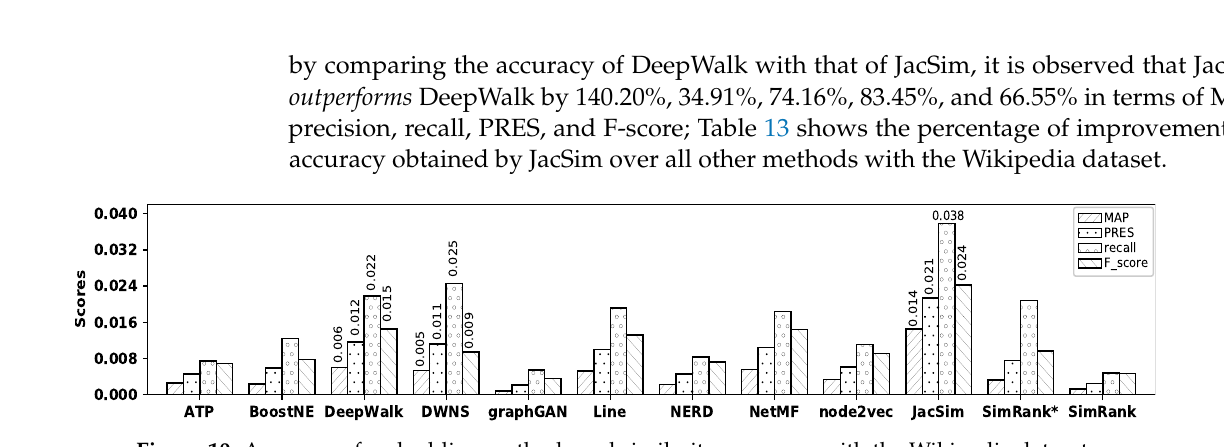
Figure 10. Accuracy of embedding methods and similarity measures with the Wikipedia dataset. Table 12. Precision values with the Wikipedia dataset.